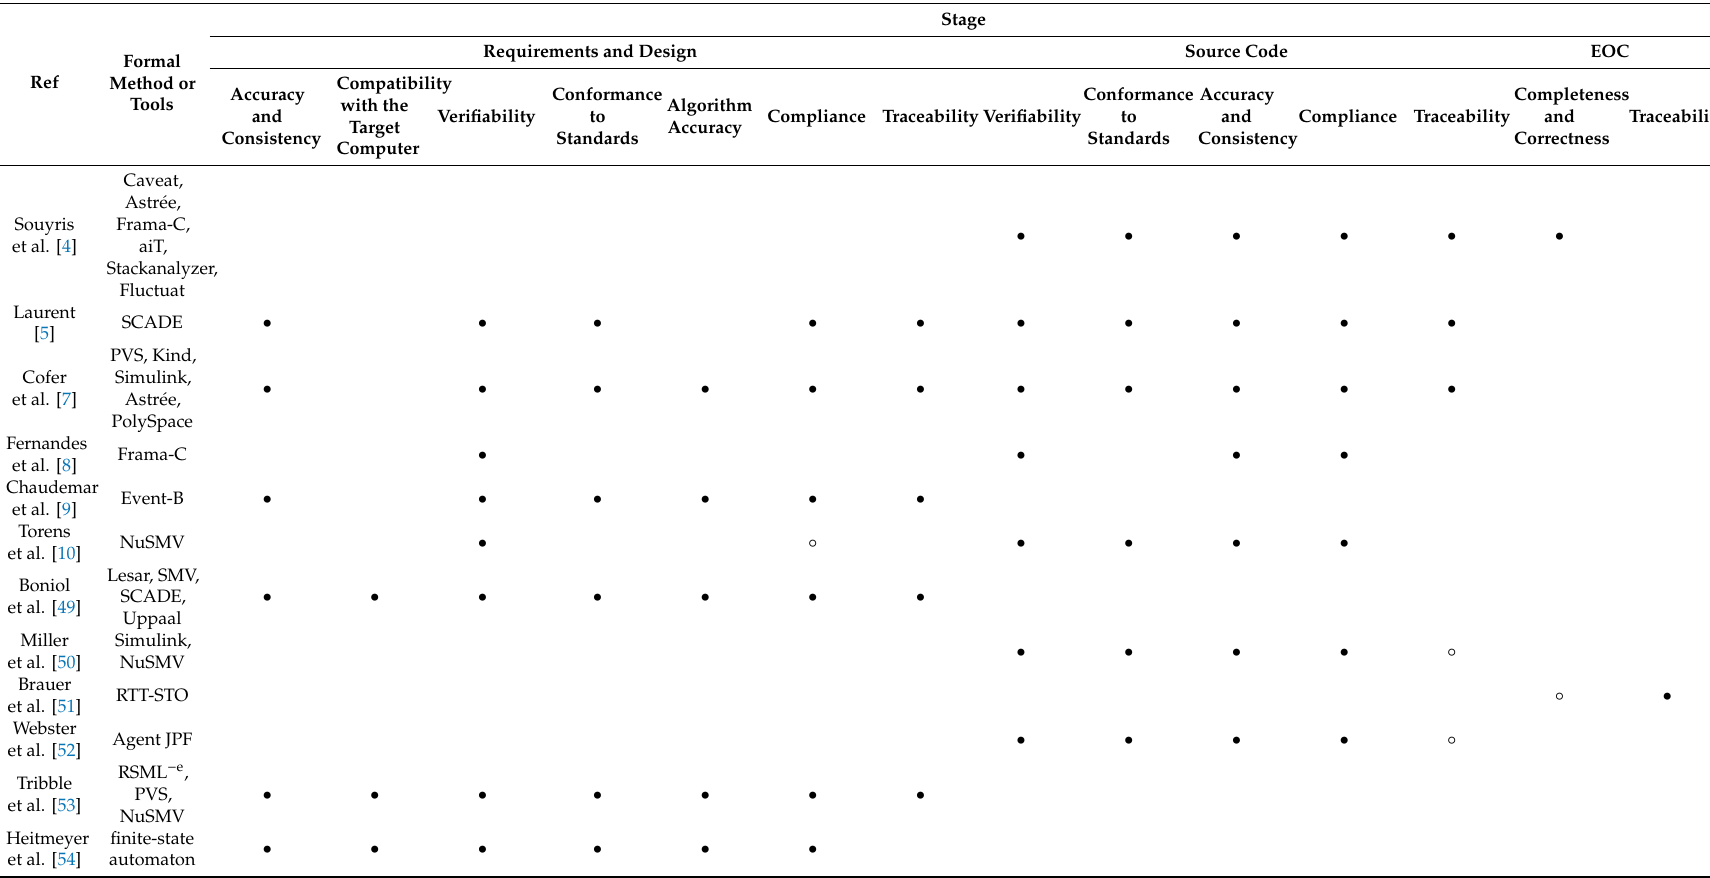
Table 1. An overview of the verification objectives achieved by formal methods in related